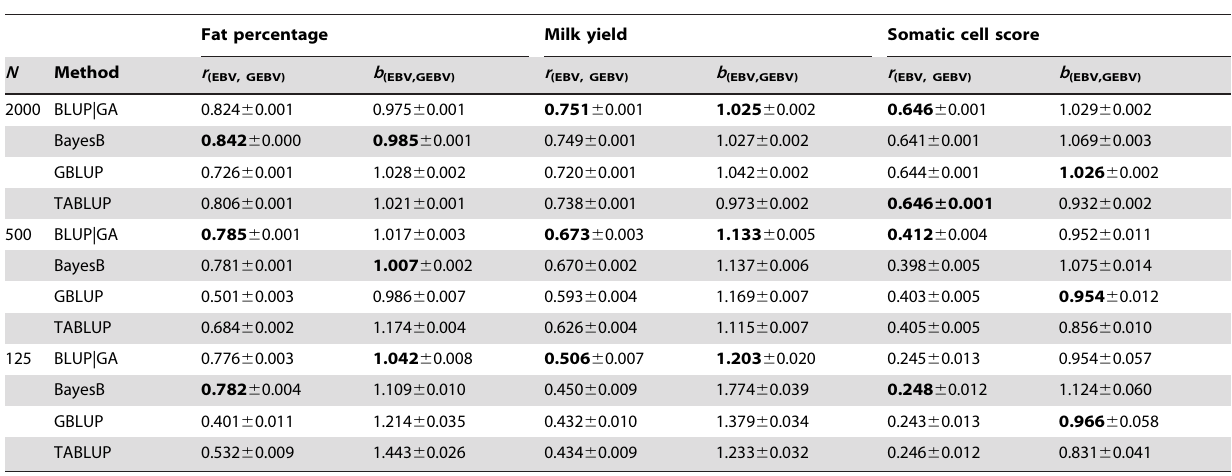
Mean ( 6 standard error of means) of accuracy ( r ) and unbiasedness ( b ) were calculated from 20 replicates of five-fold cross-validation for each of the three traits. The best result in each block is printed in